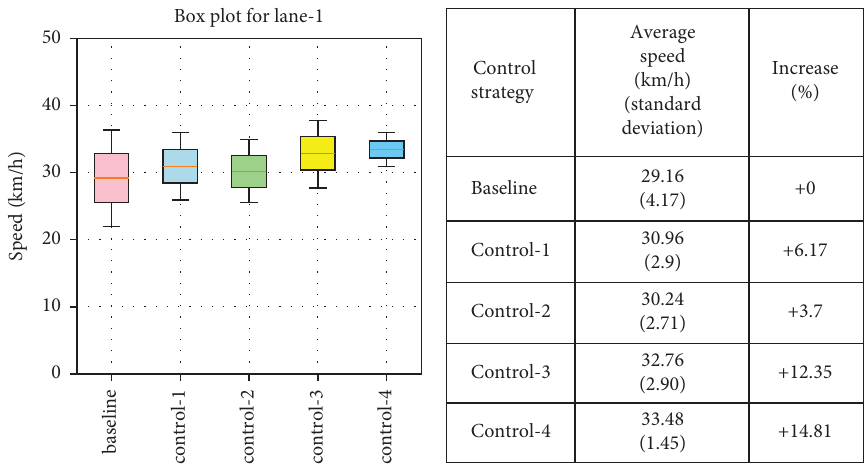
Figure 7: Vehicle speed distribution for diferent control strategies in